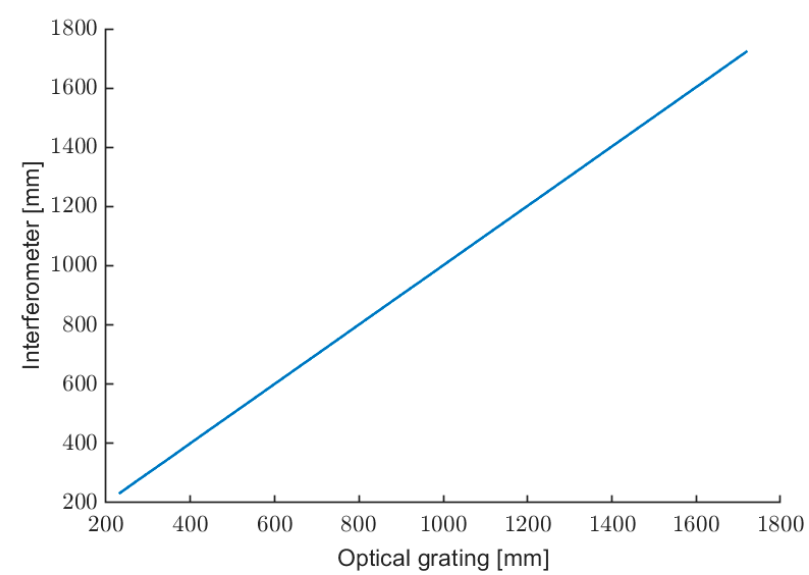
Figure 11. Characterization of the optical rangefinder.